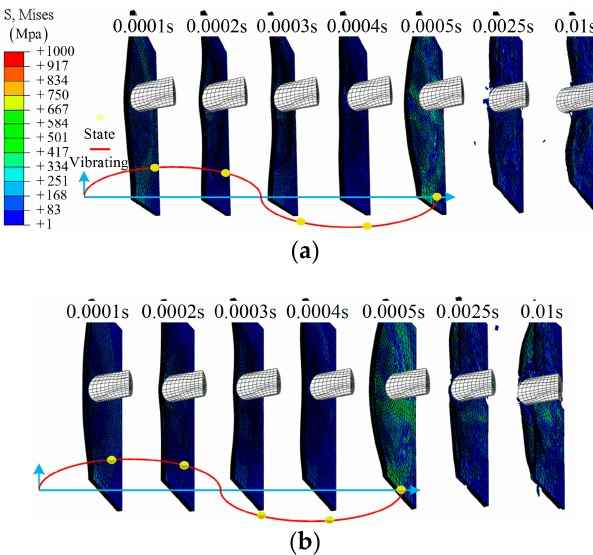
Figure 16. The cross-section of the half model during the impact: ( a ) group D4; ( b ) group E4.